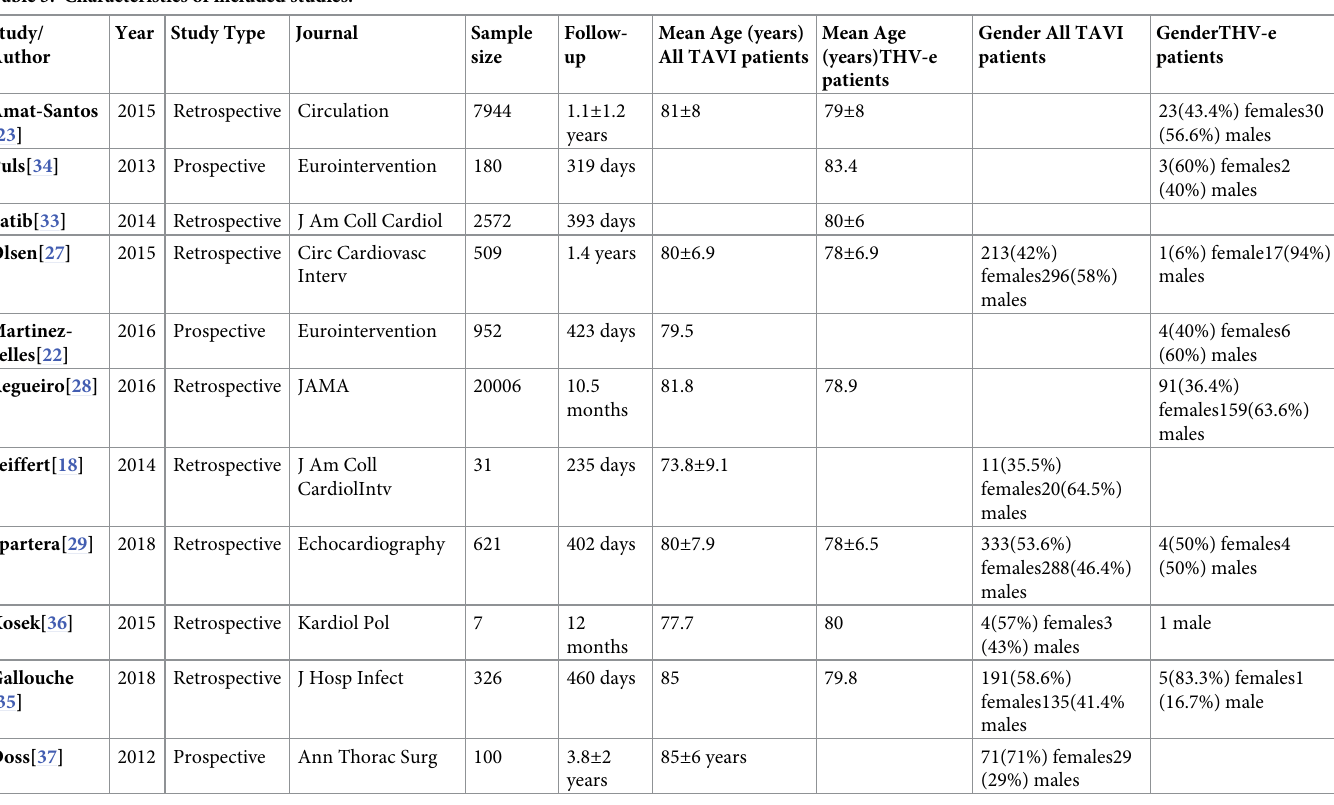
Table 3. Characteristics of included